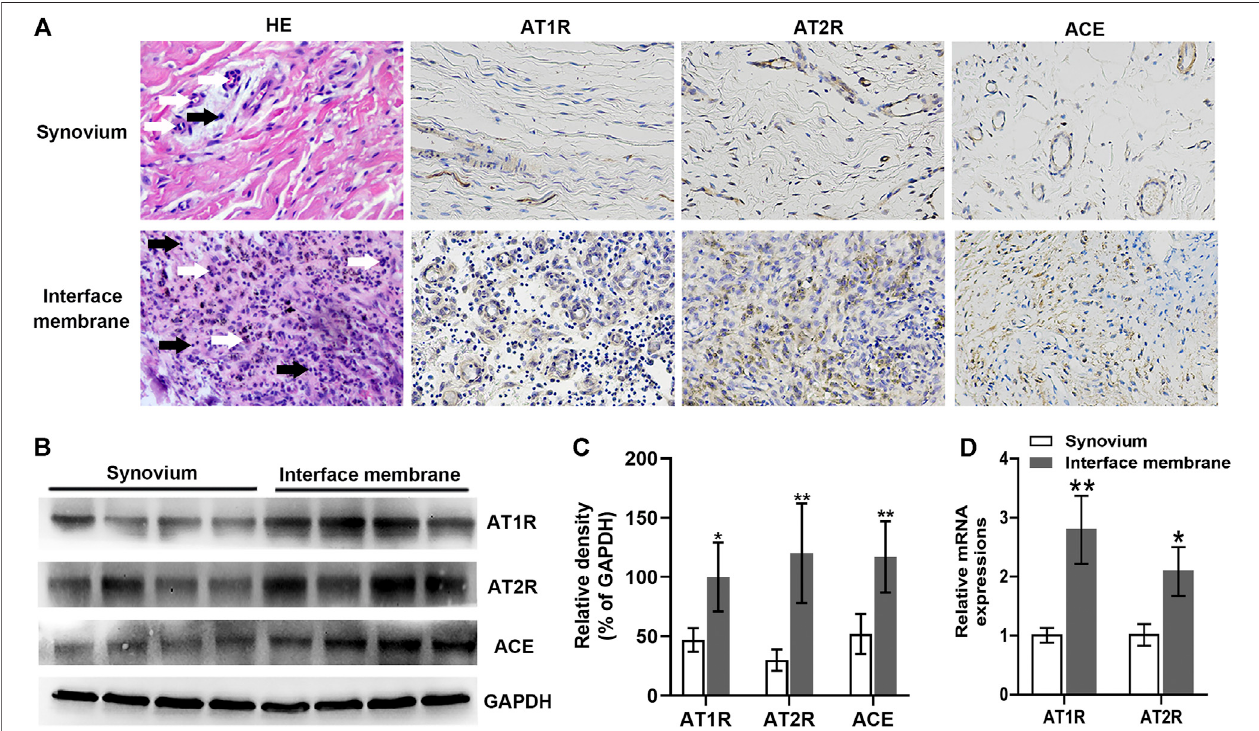
FIGURE 1 | Up-regulated AT1R, AT2R, and ACE expressions in the interface membrane tissues from patients with PPOL. The levels of AT1R, AT2R, and ACE in the interface membrane tissue from patients with PPOL and the synovial tissue from patients with femoral neck fracture were determined by H and E staining, immunohistochemistry,Westernblot,orRT-qPCR.Dataarerepresentativeimagesorexpressedasthemean ± SDofeachgroupfromthreeseparateexperiments( n (cid:1) 3 per group). (A) Representative H and E staining and immunohistochemistry images (magni fi cation × 400). Black arrows point at lymphocytes, and white arrows point at macrophages. (B,C) Western blot analyses. (D) RT-qPCR analyses. * p < 0.05 vs. the synovium group; ** p < 0.01 vs. the synovium